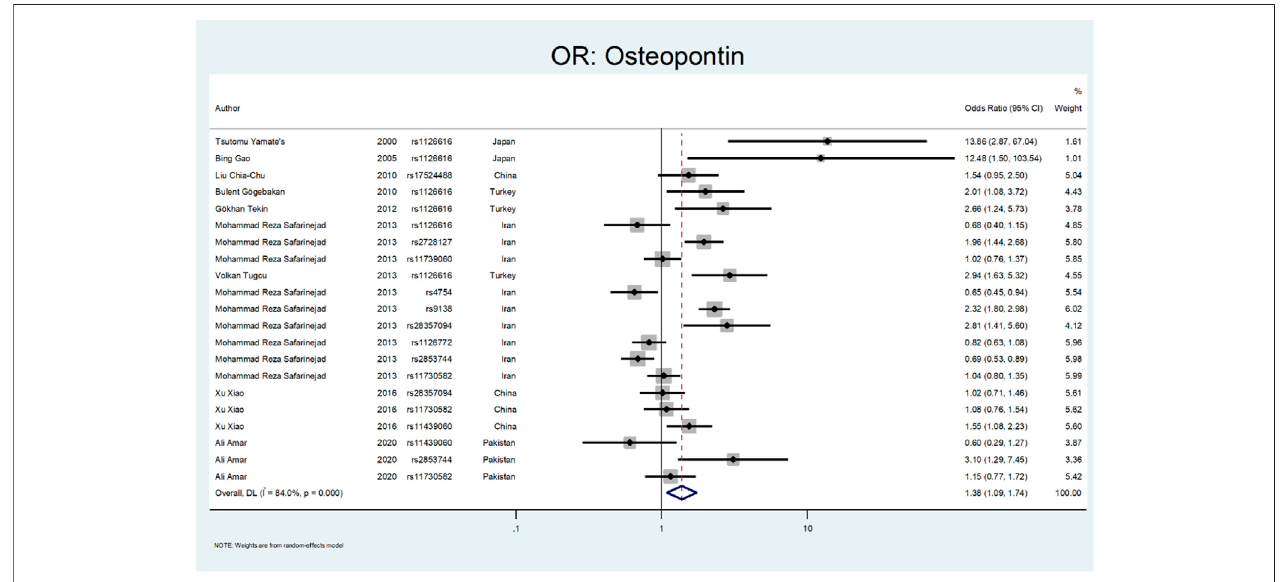
FIGURE 10 | Forest plot: OR for